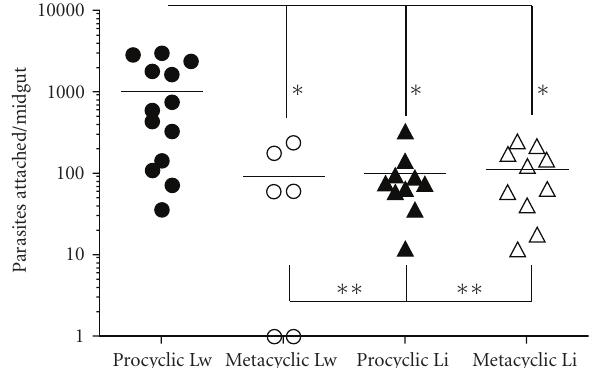
Figure 2: Di ff erential attachment of L. braziliensis (procyclic and metacyclic) to L. whitmani (Lw) and L. intermedia (Li) midguts in vitro. ∗ P < .01; ∗∗ P > .05. Data are the representation of two experiments.